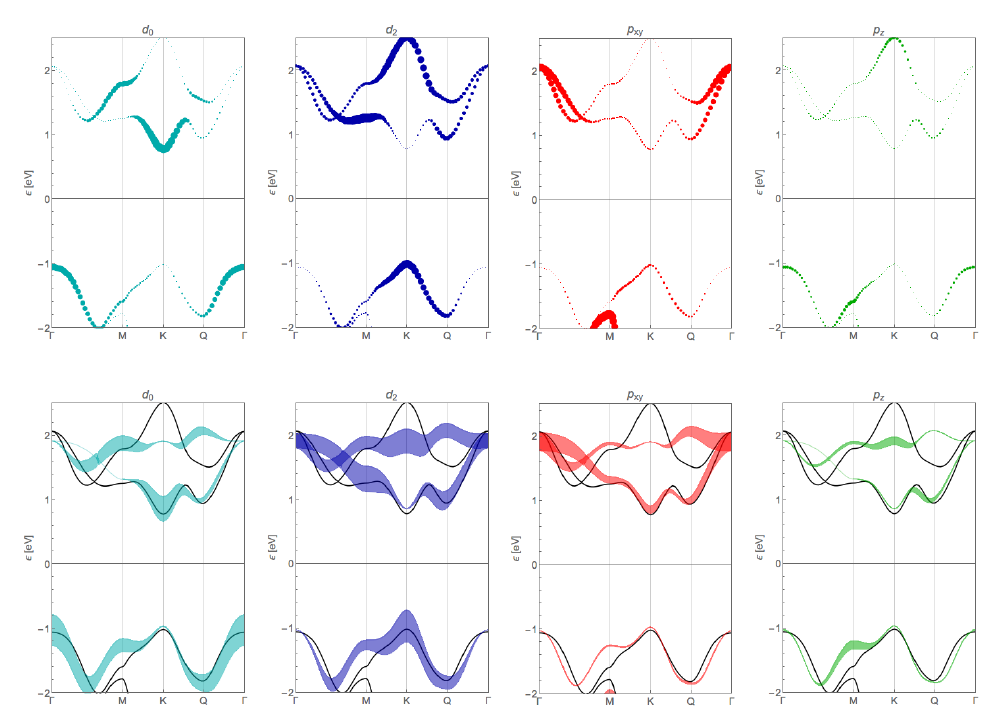
Figure 4. Band structure and orbital character of single-layer MoS 2 . The thickness of the bands represents the orbital weight, where the d character ( d 2 = d x 2 − y 2 , d xy and d 0 = d 3 z 2 − r 2 ) refers to the Mo atom 4 d orbitals, while the p character (where p xy = p x , p y ) refers to 3 p orbitals of sulfur. Top panels correspond to orbital weight from DFT calculations, whereas bottom panels correspond to orbital weight from TB results. The black lines in the bottom panels are the DFT bands. Notice that spin–orbit coupling is not included in these